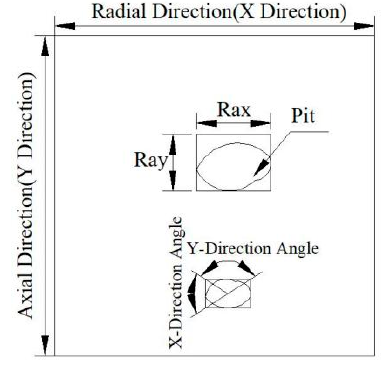
Figure 6. Micro-surface of a wheat stalk.